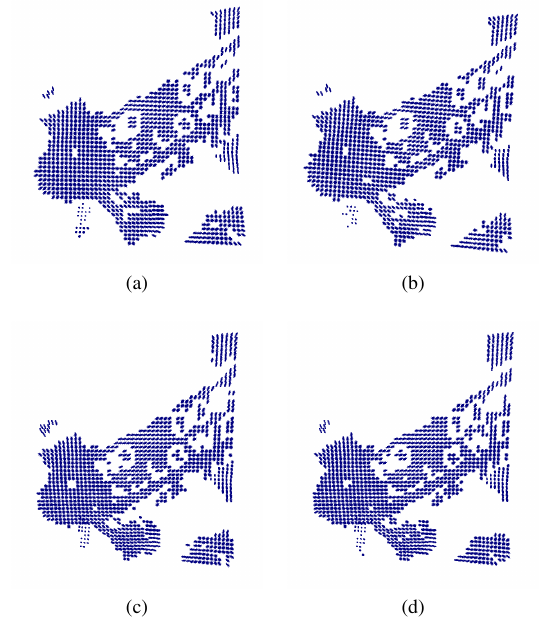
Fig. 18: (a) Target object in frame 1. (b) Visualization of the point cloud in frame 2. (c) Point cloud in frame 3. (d) Target point cloud in frame 4.